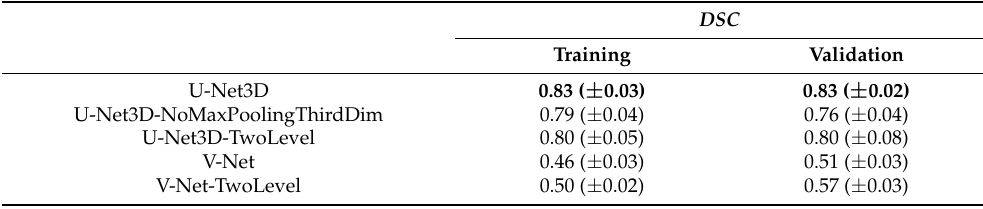
Table 2. Cross-validation results: DSC values obtained from each model in training and validation